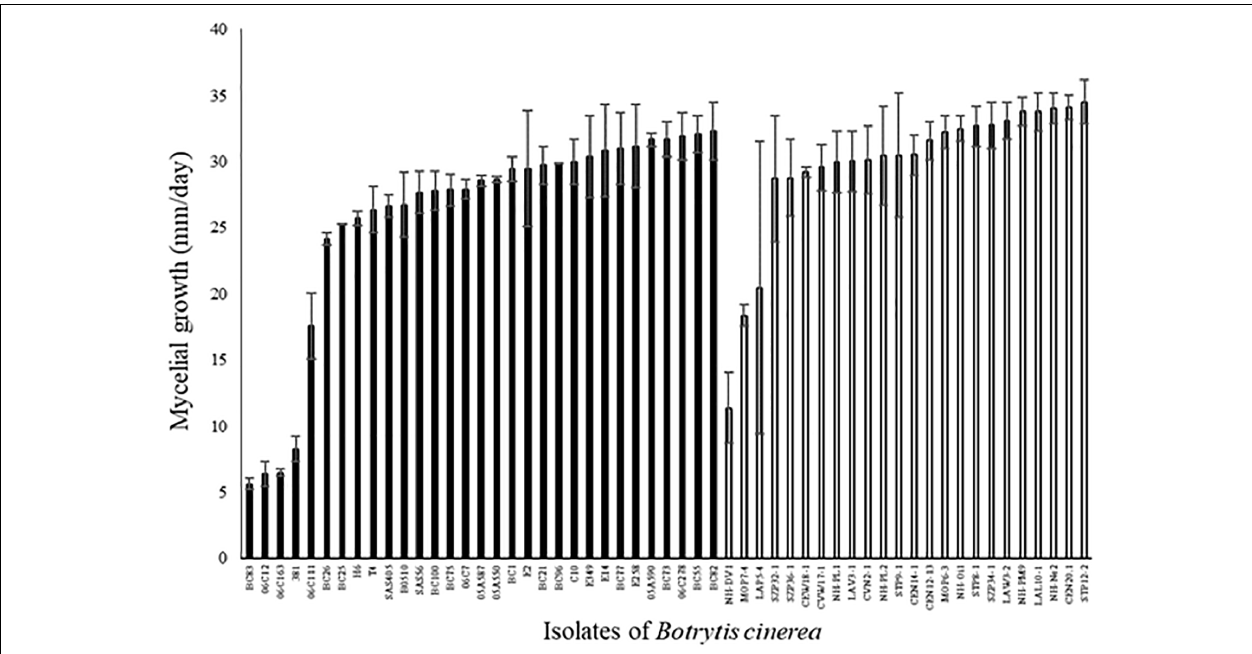
FIGURE 3 | Mycelial growth (mm/day) of 31 agricultural (black) and 24 environmental (white) strains of B. cinerea on PDA medium in controlled condition (21 ◦ C, photoperiod 14 h, 114 µ mol m − 2 s − 1 ). Each value represents the mean of two independent repetitions. The vertical bar associated to each histogram correspond to SE.